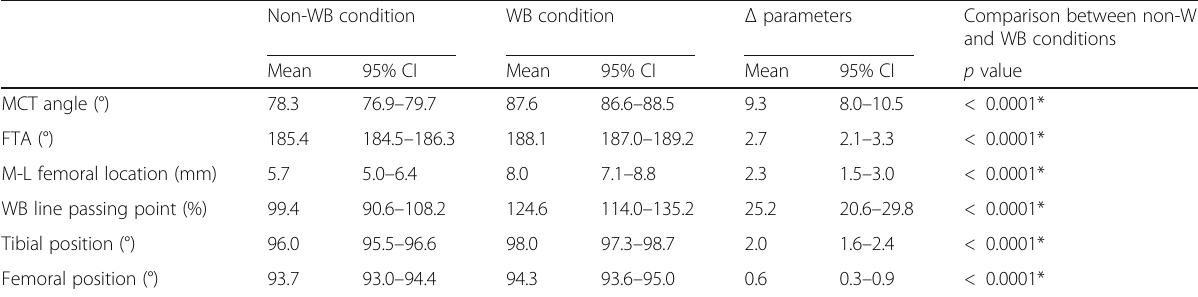
Table 1 Evaluation parameters Non-WB condition WB condition Δ parameters Comparison between non-WB